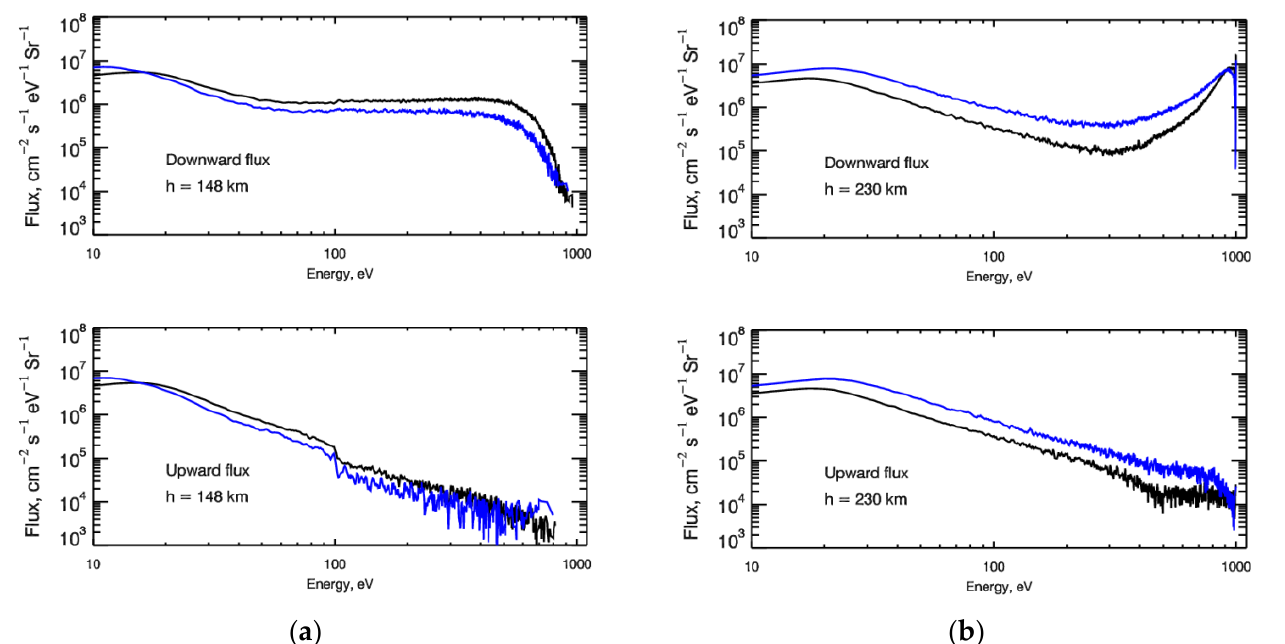
Figure 1. ( a ) Energy spectra of downward ( top panel ) and upward ( bottom panel ) fluxes of auroral electrons calculated at height of 148 km. Auroral electrons are represented by monoenergetic flux with energy E 0 = 1 keV and are characterized by monodirectional (black lines) and isotropic (blue lines) pitch-angle distributions at the upper boundary. ( b ) Same as ( a ) but at height 230 km. Height profiles of the calculated downward (solid lines) and upward (dashed lines)